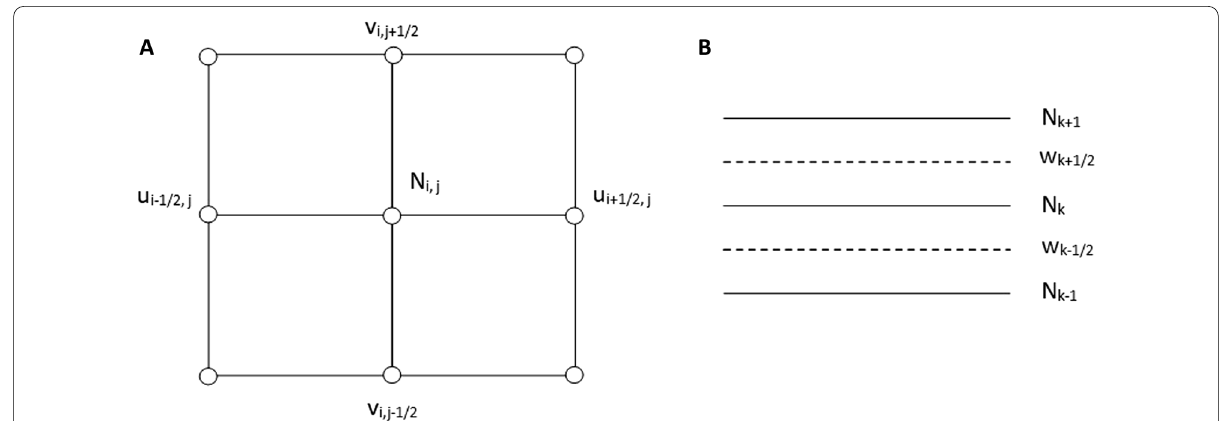
Fig. 1 The DISVERMAR horizontal and vertical computational grid ( A , B panels,